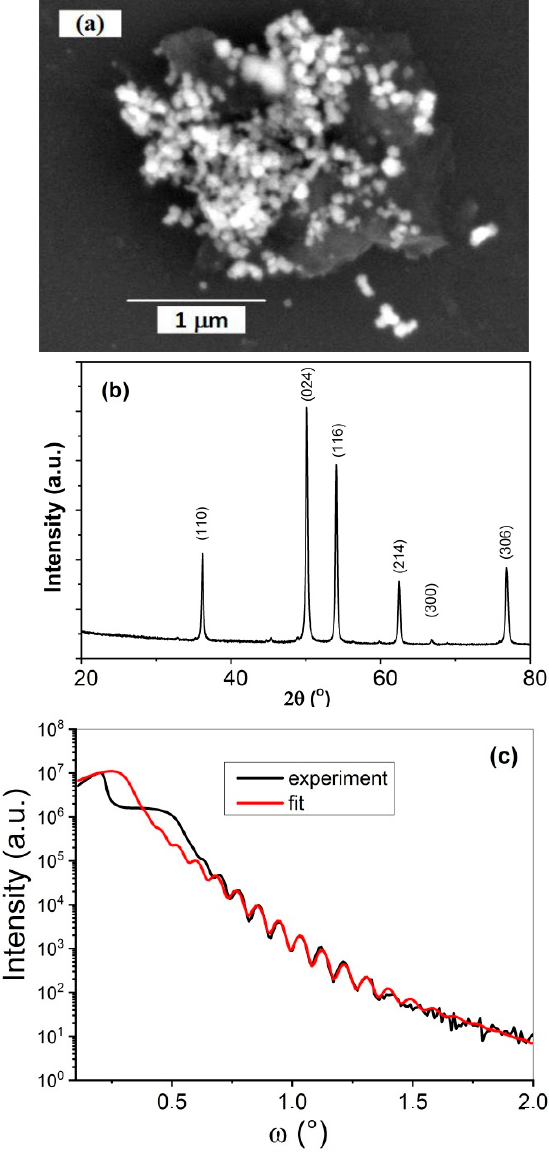
Figure 3. ( a ) SEM image of GO/ α -Fe 2 O 3 structure, ( b ) X-ray diffraction pattern for α -Fe 2 O 3 , ( c ) X-ray reflectivity pattern for GO/ α -Fe 2 O 3